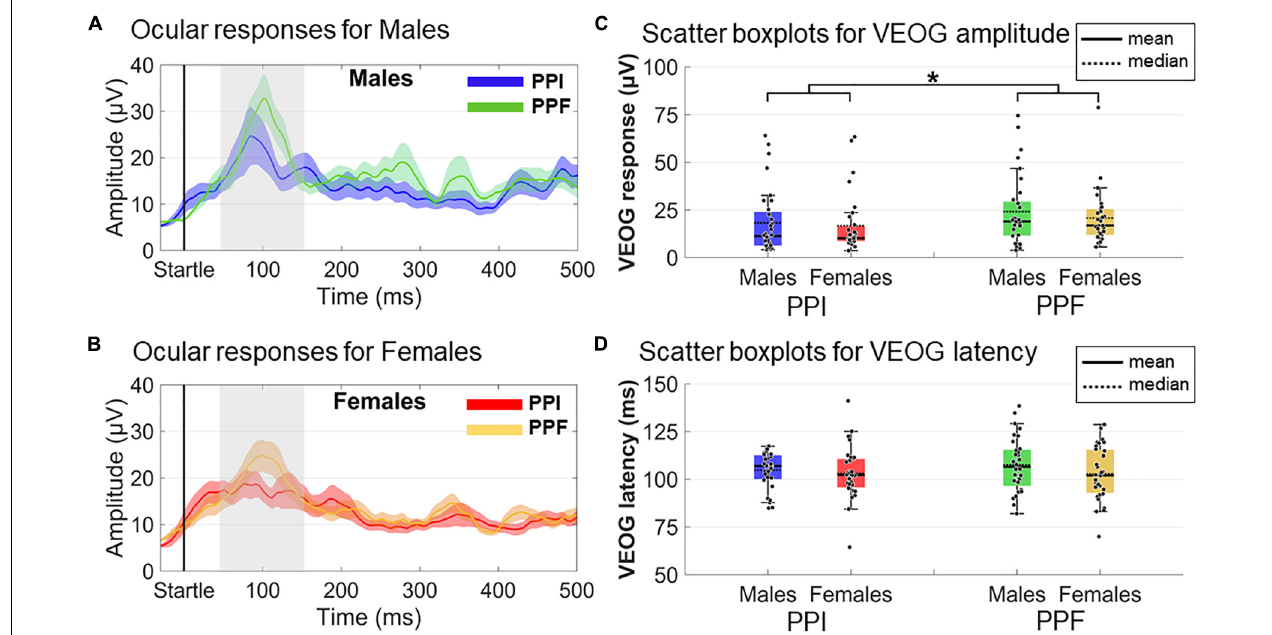
FIGURE 5 | Grand-averaged VEOG responses for each group (males vs. females) and condition (prepulse inhibition, PPI, vs. prepulse facilitation, PPF). In panels (A,B) , the time course of the VEOG responses is illustrated for males (PPI: blue, PPF: green) and females (PPI: red, PPF: orange), respectively, from –30 to 500 ms (time 0 is the startle onset). Color-shaded areas correspond to the time course of the standard error ( ± 1 SE) of the mean. In panels (C,D) , the individual samples and descriptive statistics (mean and median) are depicted in scatter boxplots, separately for amplitudes and latencies, respectively. *Significance at p <